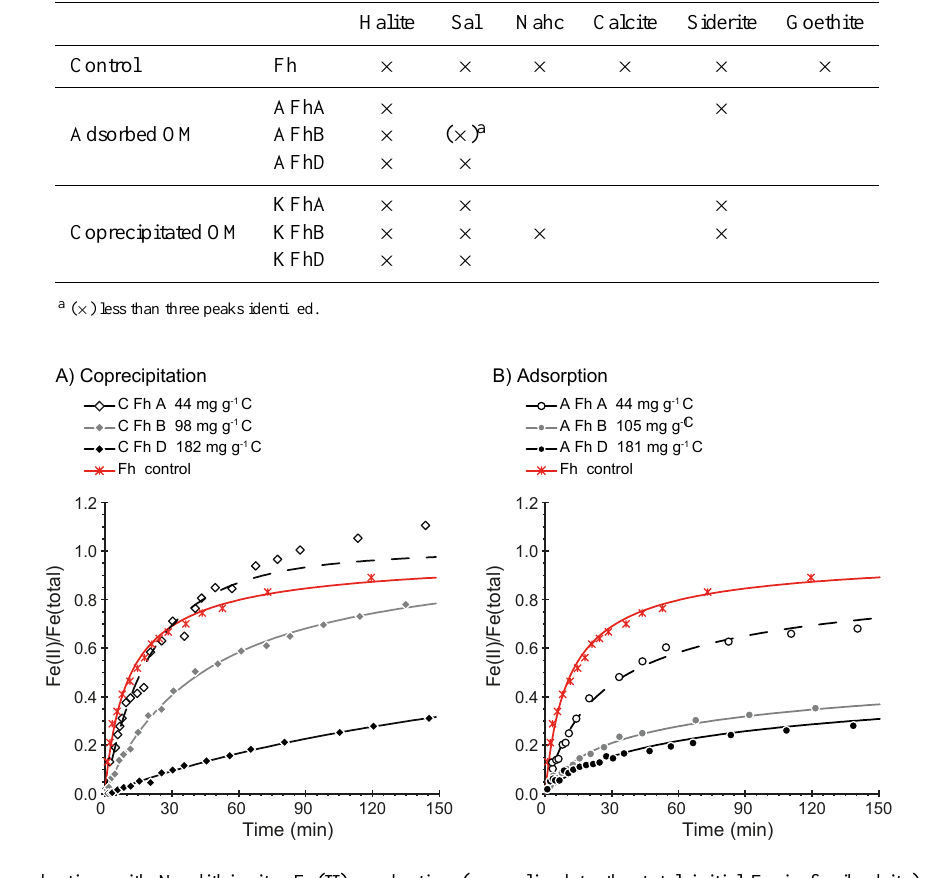
Figure 7. Abiotic reduction with Na-dithionite: Fe(II) production (normalized to the total initial Fe in ferrihydrite) versus time. Lines represent the model by Christoffersen and Christoffersen (1976). Note that the dissolved Fe(II) was estimated to be larger than the total Fe for sample CFhA, which is